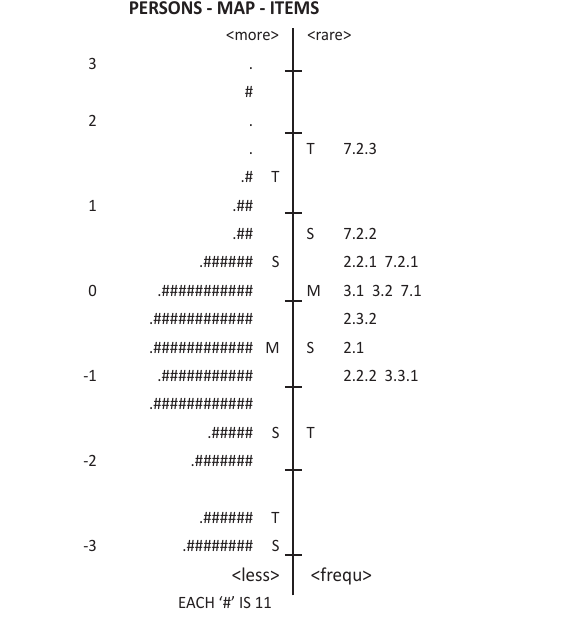
FIGURE 1: Person-item-map.